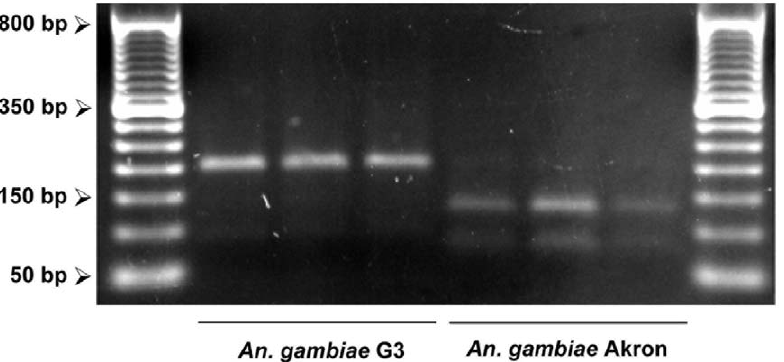
Figure 1. PCR amplification of G119/S119 region in single individuals of An.gambiae susceptible (G3) and resistant (Akron) strains. Genomic DNA amplification with Moustdir1 and Moustrev1 degenerate primers produce a 194 bp fragment, which is undigested by Alu I for susceptible mosquitoes (G3 strain) and digested into two fragments (122 and 72 bp) for homozygous resistant mosquitoes (Akron strain).